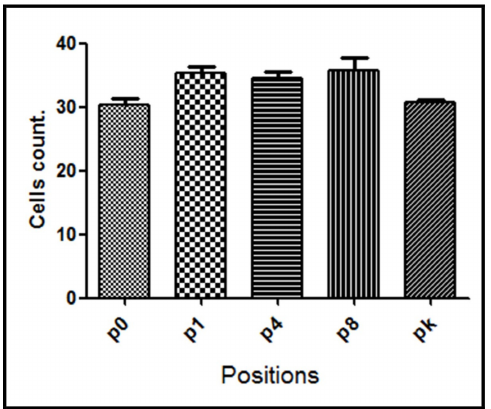
Figure 4. NF- κ B positive cell count for G1 group evaluated at different positions from the bone lesion. The mean number with the corresponding standard deviation is shown for each point.